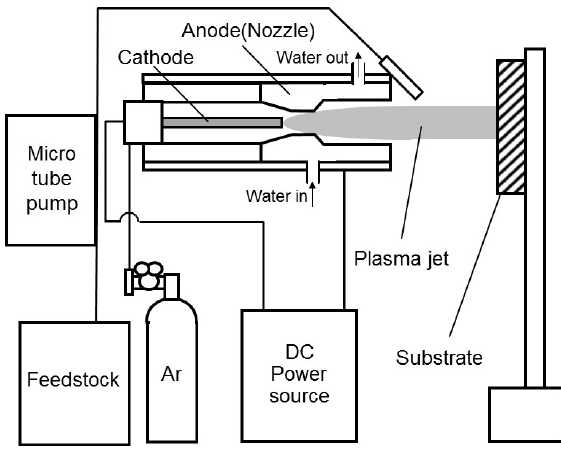
Figure 3. Schematic diagram of the SPS equipment.